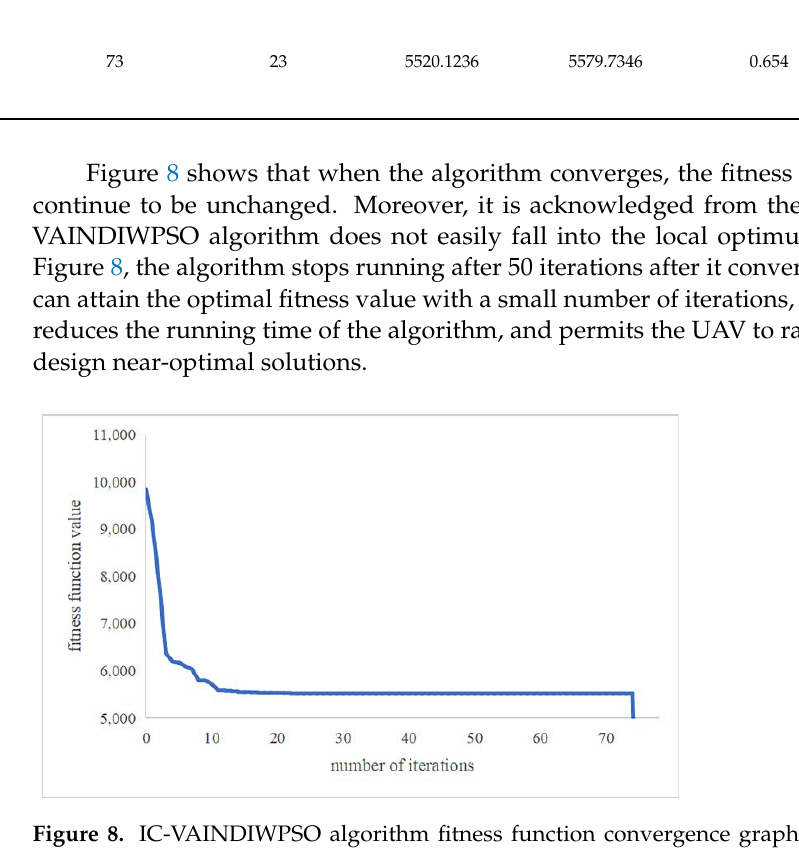
Table 5. Algorithm data comparison.